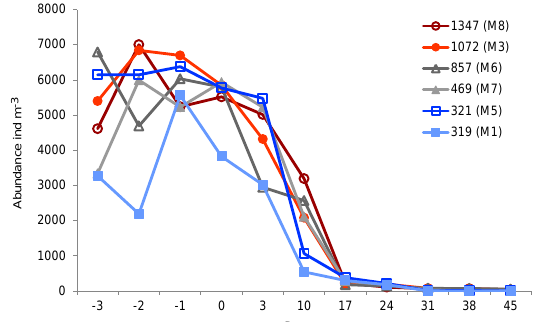
Figure 1. Larval abundance in the water column of the individual mesocosms over time.